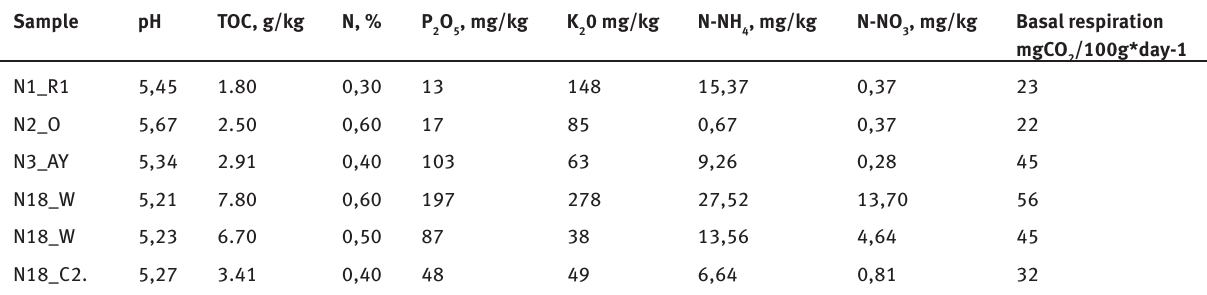
Table 1: Basic agrochemical properties of soils Sample